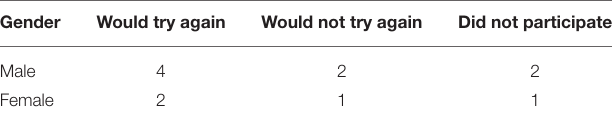
TABLE 1 | Socio-demographic characteristics of village interviewees in central Malawi near the Bunda College of Agriculture ( N = 16). Characteristic